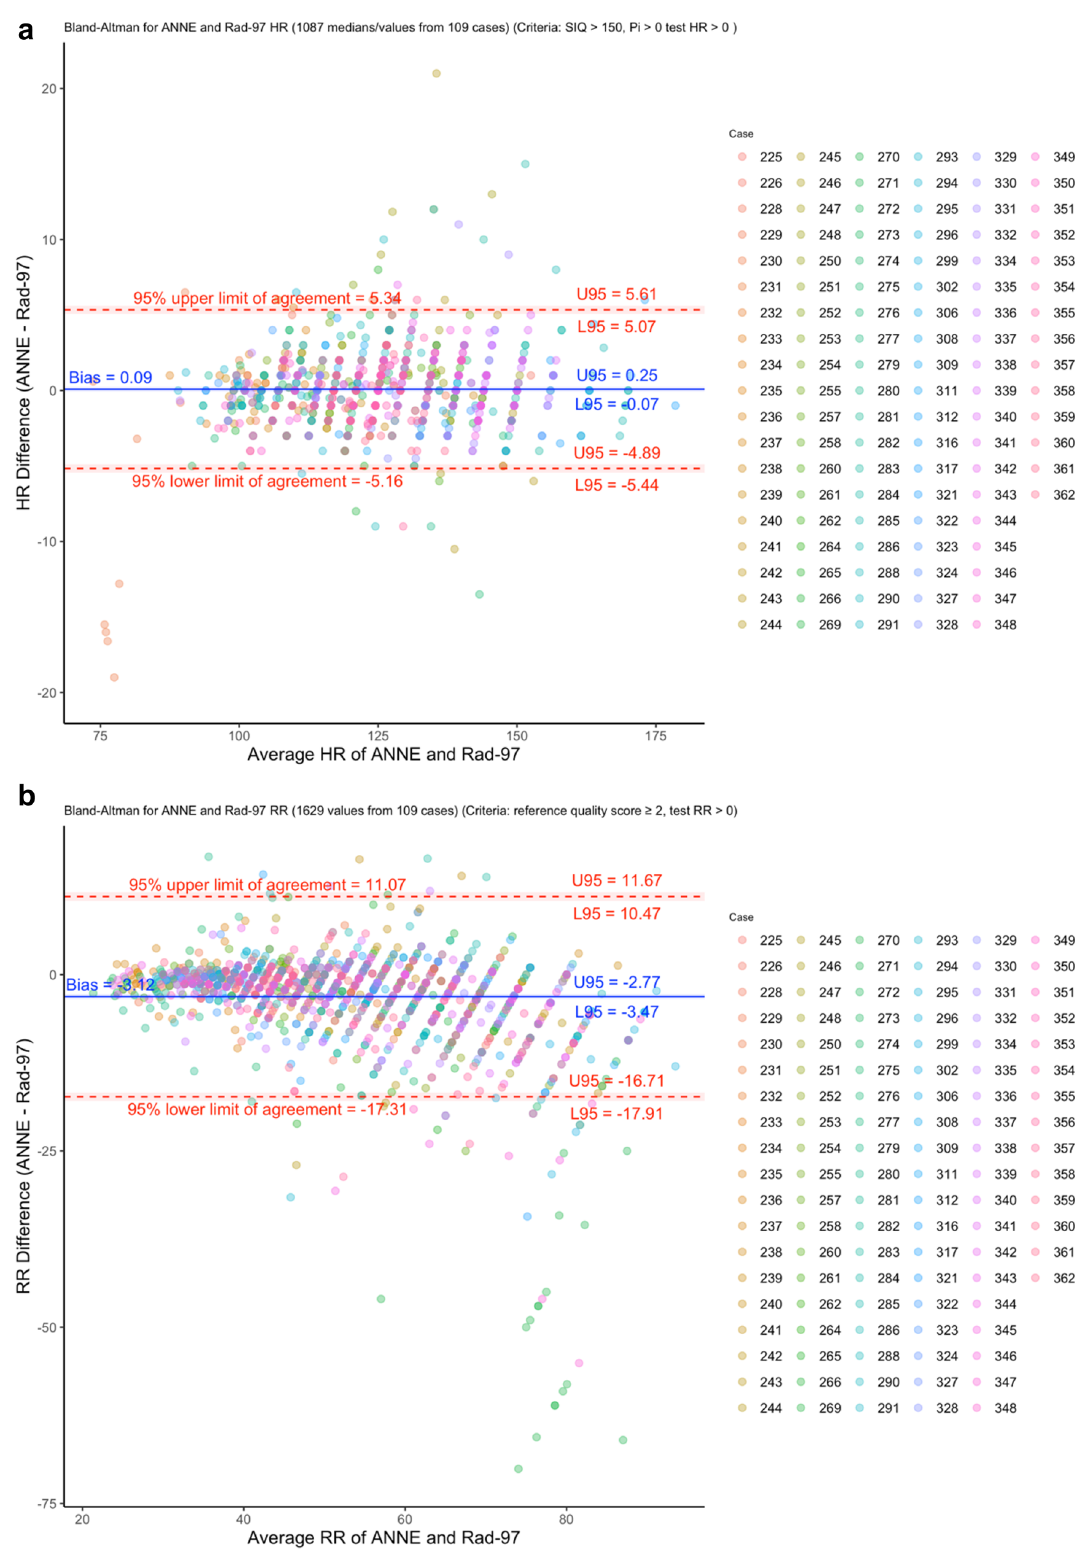
Figure 3. Bland–Altman plots of measured ( a) heart rate (HR), ( b) respiratory rate (RR) , (c) oxygen saturation (SpO 2 ), and ( d) temperature as measured by ANNE and the reference technologies. Colors indicate which participant neonate is associated with the measurement